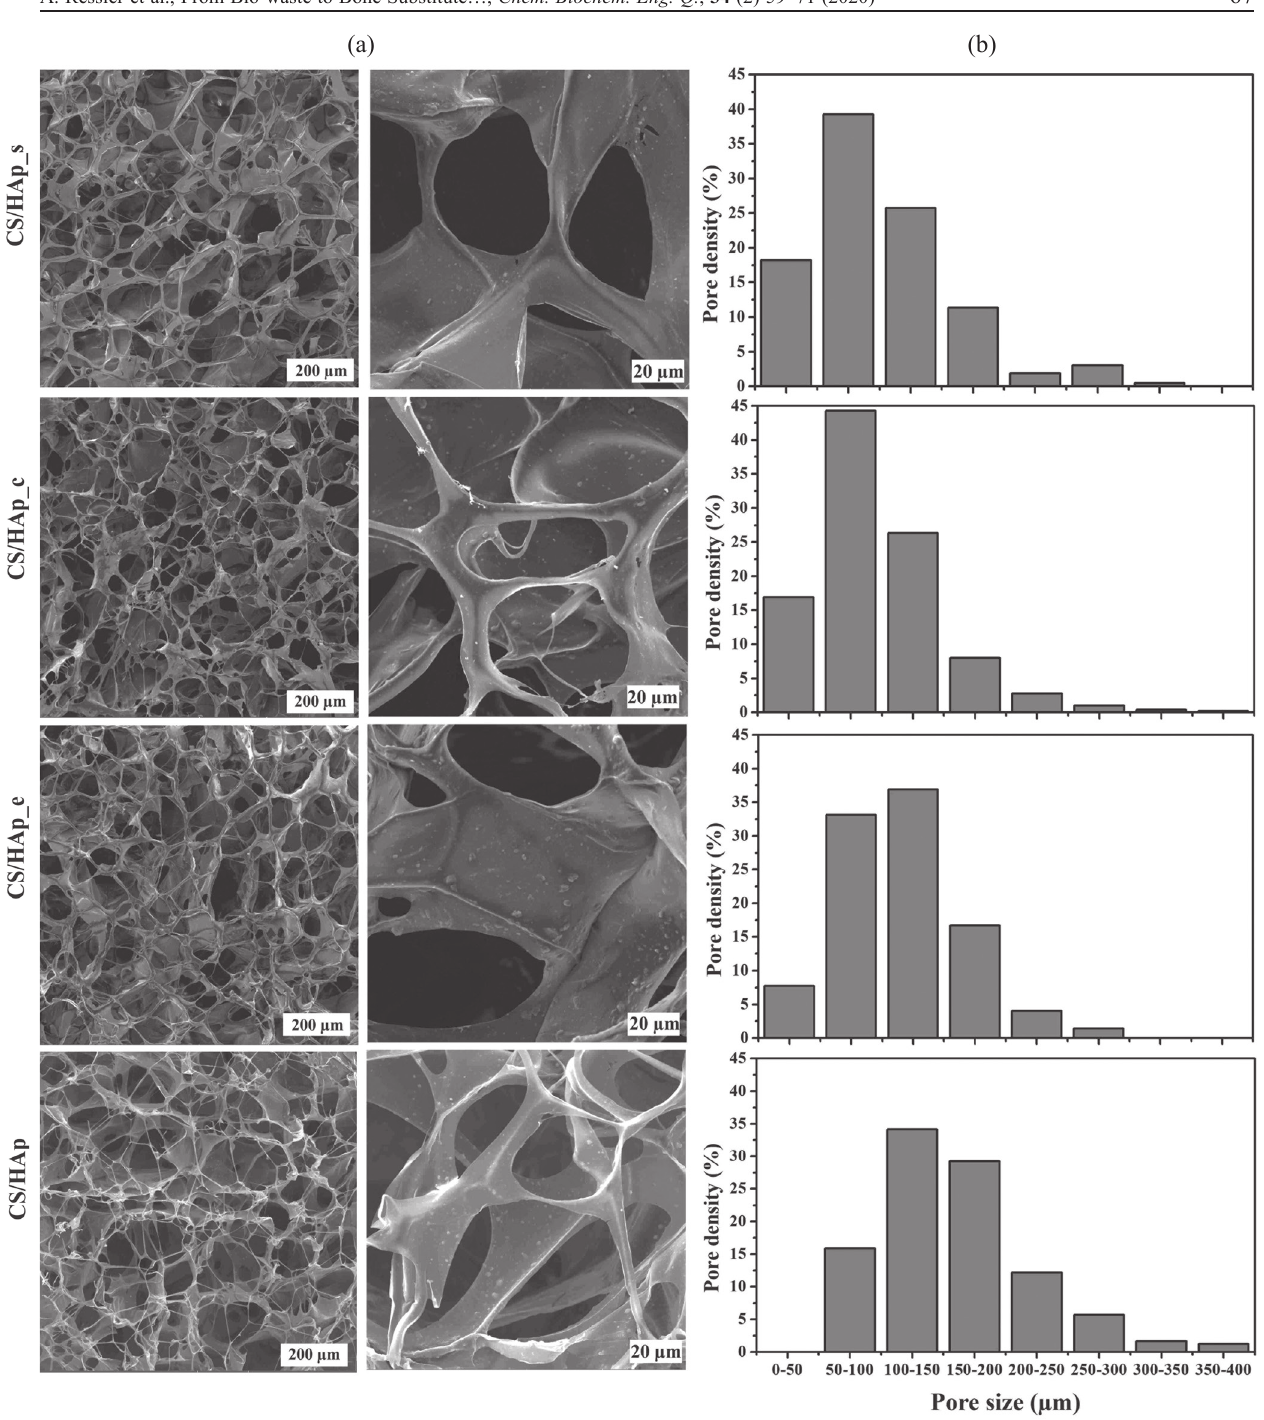
Fig. 5 – Microscopic imaging (a) and pore size distribution (b) of prepared composite scaffolds obtained from different biogenic sources. Scale bar: 200 and 20